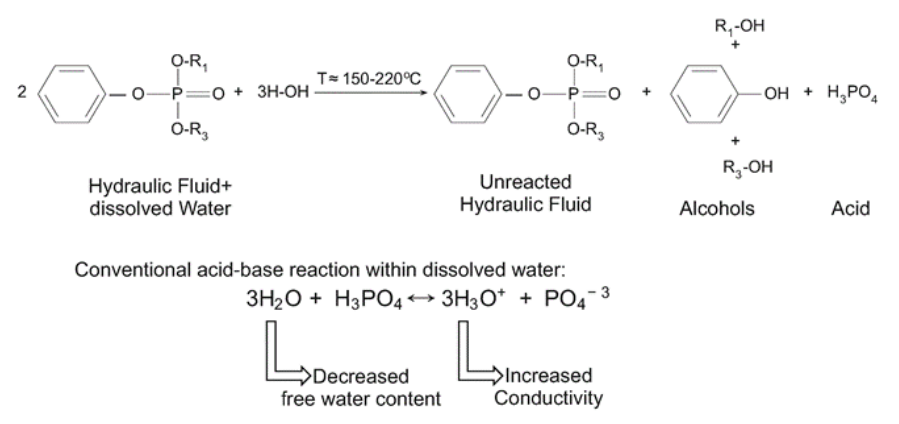
Figure 2. Chemical reactions following the take-up of water into a phosphate-ester based hydraulic fluid, yielding split-o ff alcohols and partial phosphates, ultimately producing phosphoric acid and fluid, yielding split-off alcohols and partial phosphates, ultimately producing phosphoric acid and H 3 O + ions via reaction with the dissolved water H 3 O + ions via reaction with the dissolved water [6].